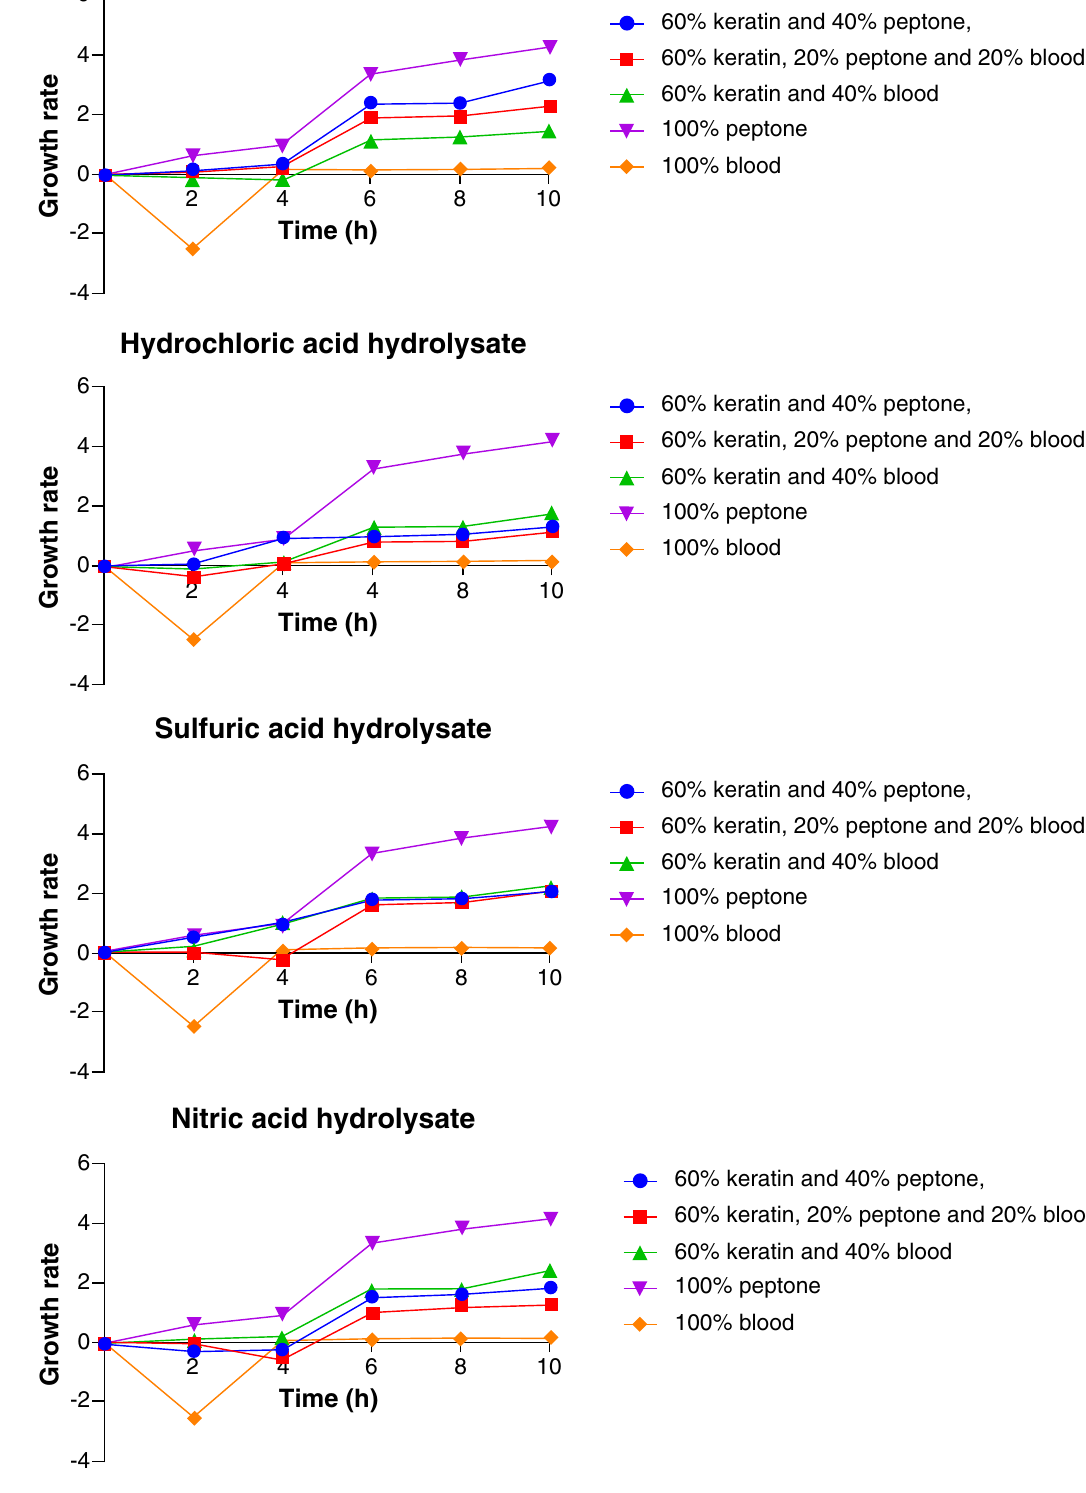
Figure 5. Growth rate of Pseudomonas aeruginosa in media with the TCA, HCl, H